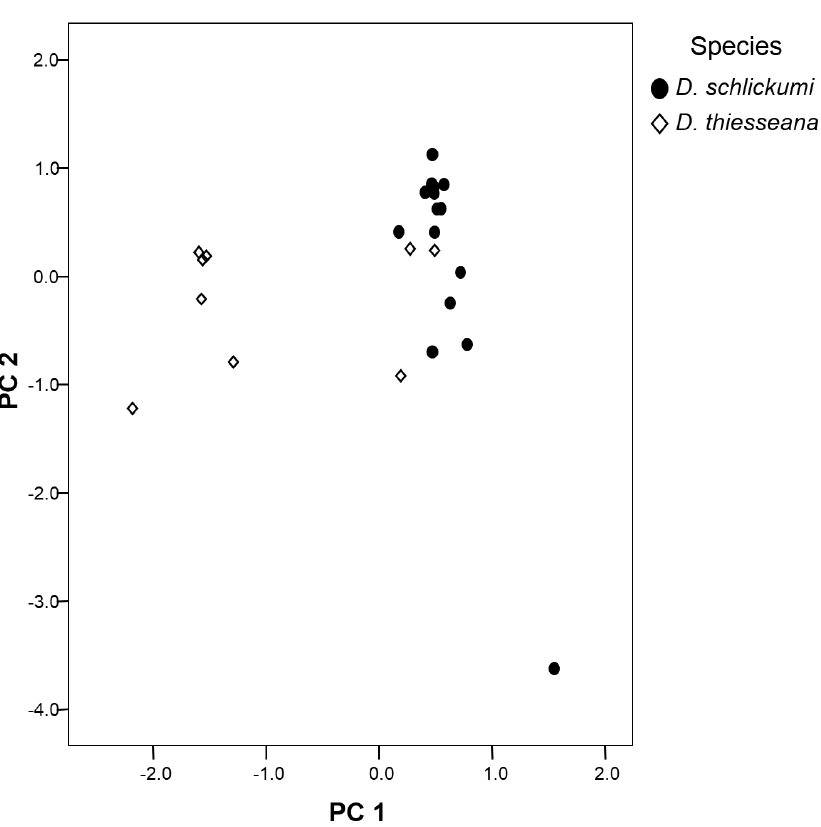
Figure 9. Principal component analysis of Procrustes coordinates for Dianella schlickumi (black circles) and for Dianella thiesseana (open